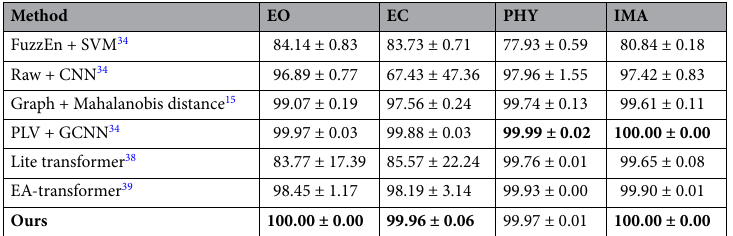
Table 1. Results of models training and testing within each human state. Results are accuracy in testing stage (average ± standard deviation)%. Significant values are in [bold].